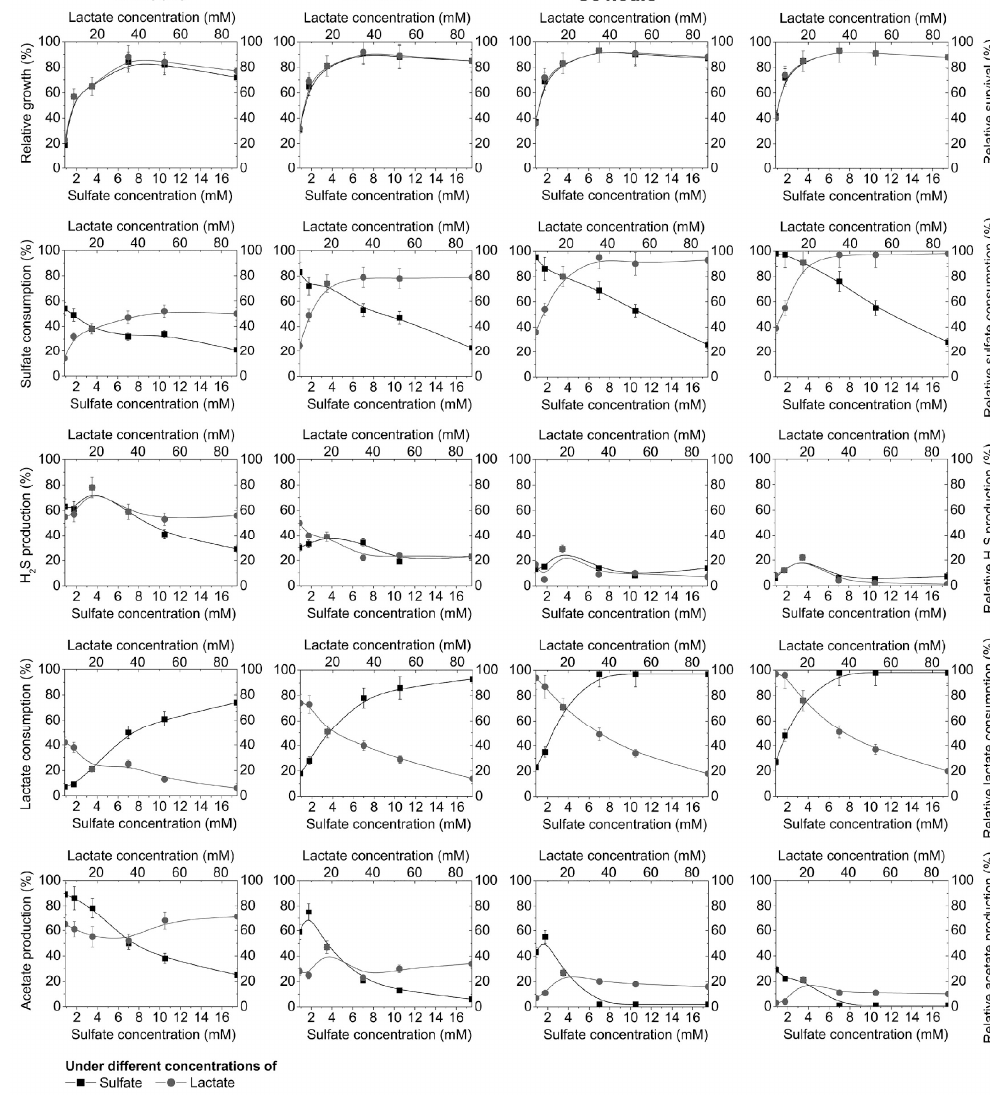
Figure 2. Growth of D. piger Vib-7, and their survival and sulfate reduction parameters during 12, 24, 36, and 48 h of cultivation: the effect of electron acceptor (sulfate)/donor (lactate) at different concentrations (columns: first = 12 h, second = 24 h, third = 36 h, fourth = 48 h).